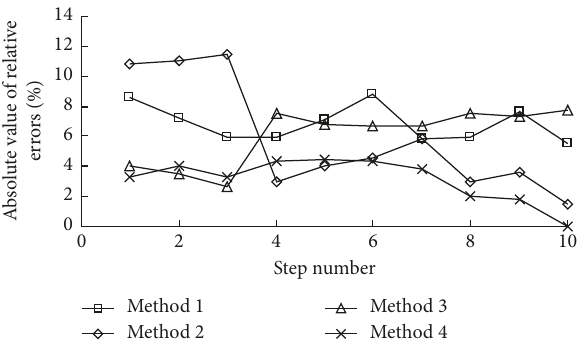
Figure 7: Absolute value of the relative errors from the prediction results from subseries X 2 . 4 .